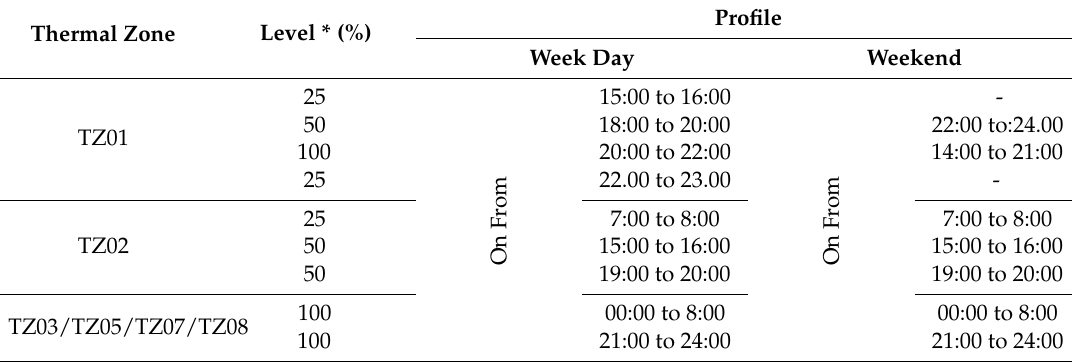
Table 2. Occupancy schedule of relevant thermal zones TZ0#.